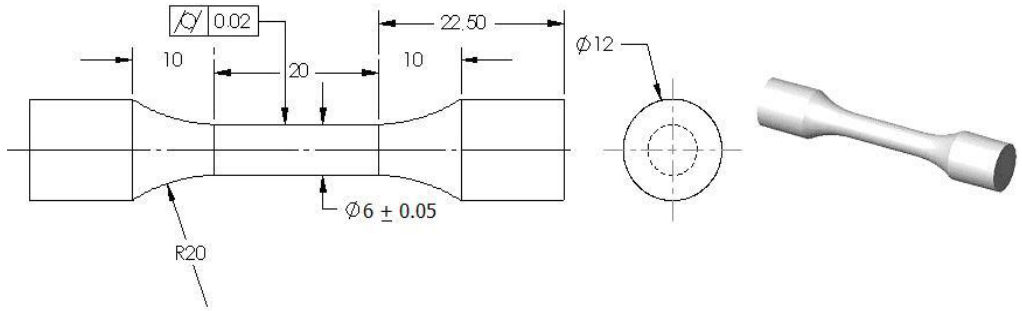
Figure 4. Dimensions (in mm) of the torsion test specimen.